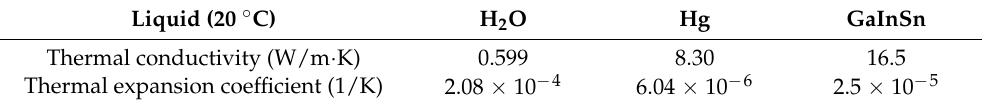
Table 1. Thermal conductivity and thermal expansion coefficients of three liquids.